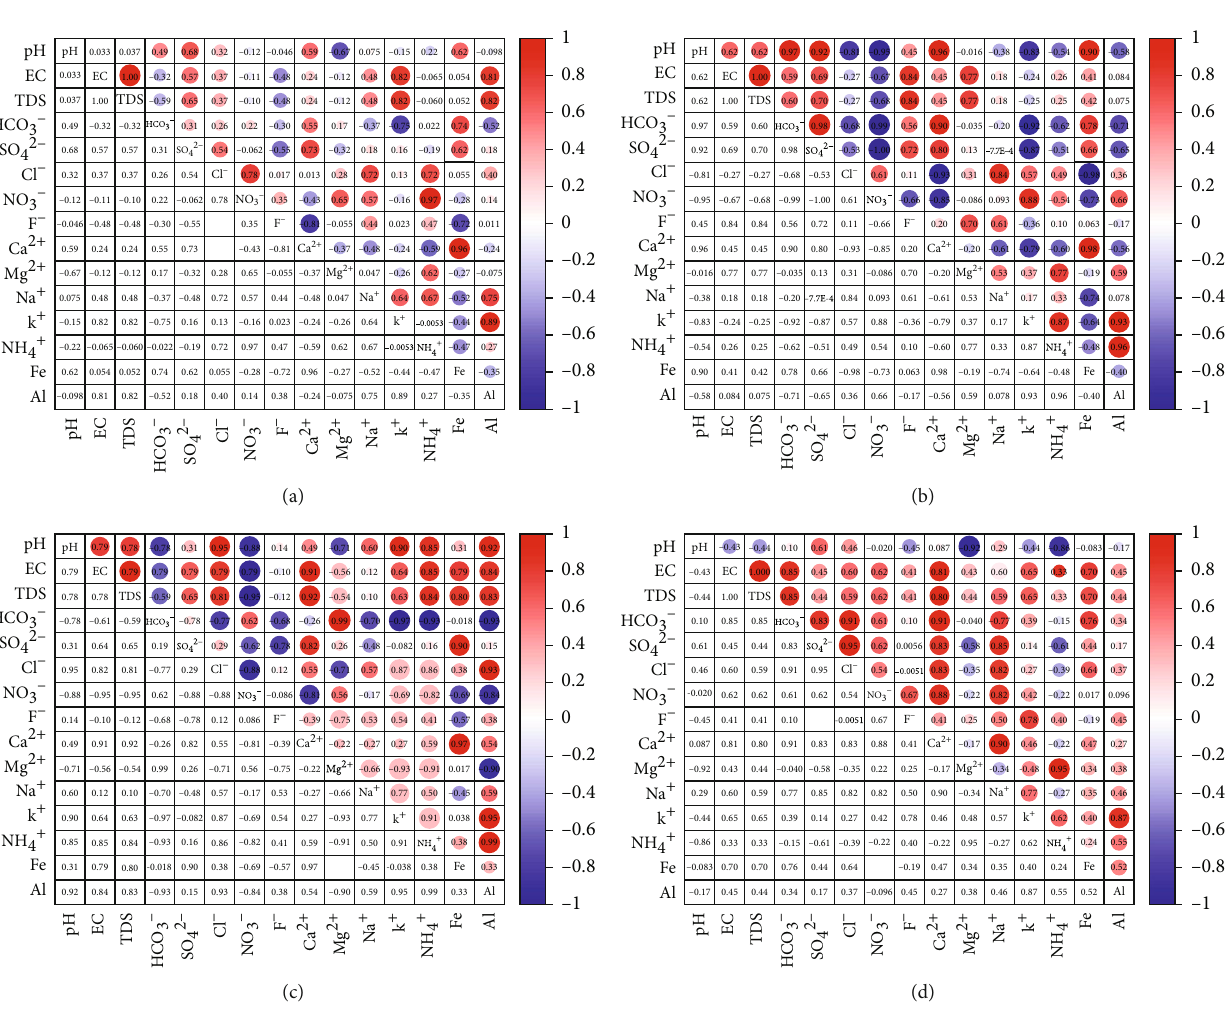
Figure 9: Correlation matrix of ions in groundwater in the study